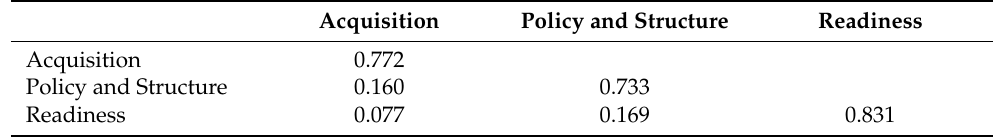
Table 5. The result of the Fornell-Larcker criterion constructs. Acquisition Policy and